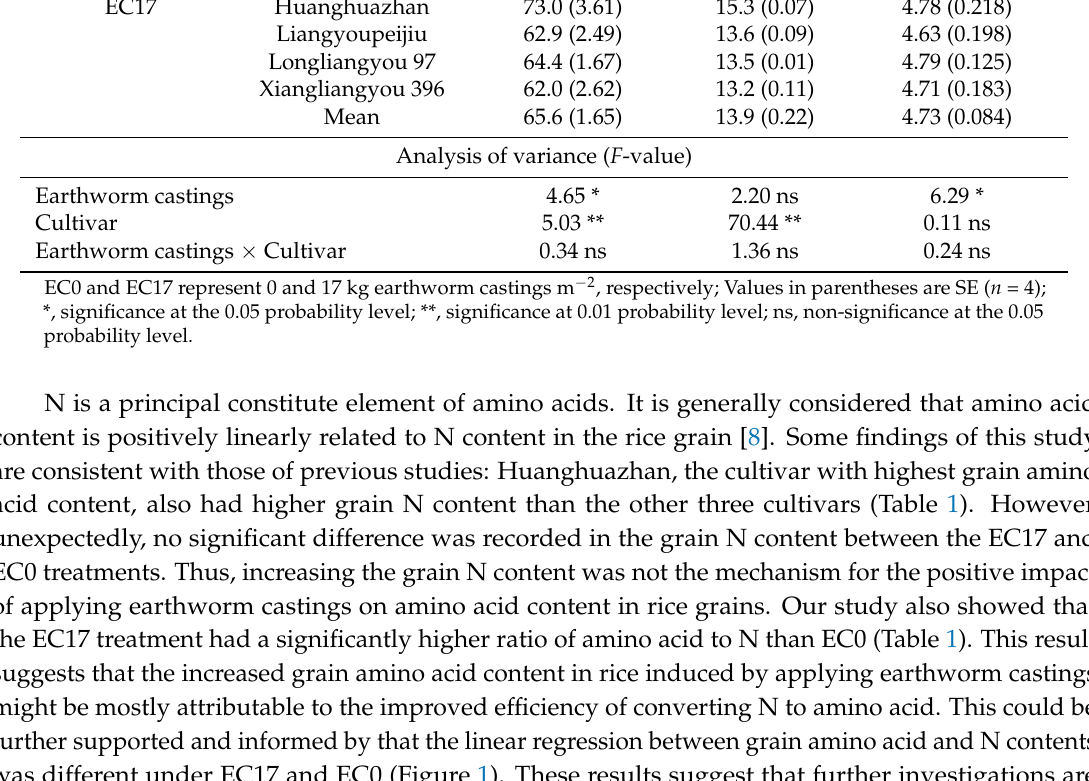
Table 1. Effects of earthworm casting application on total amino acid and nitrogen (N) content and on ratio of amino acid to N in grains of four rice cultivars.